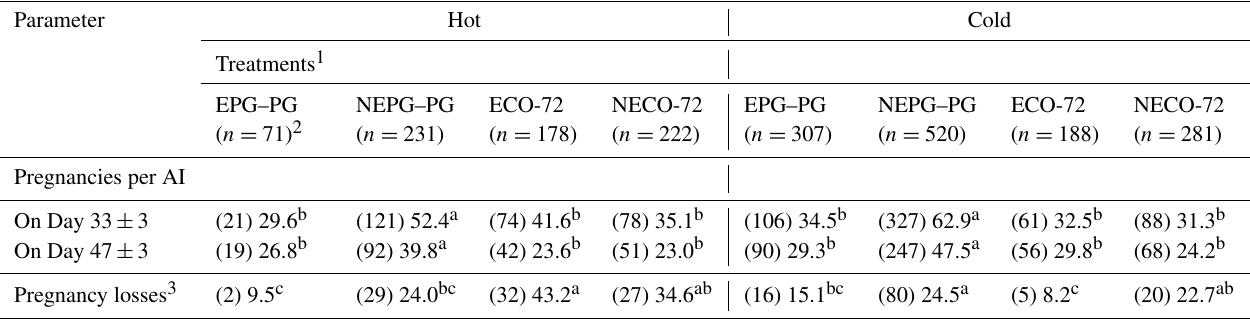
Table 6. Pregnancies per AI and pregnancy losses for cows based on treatment–season interaction.